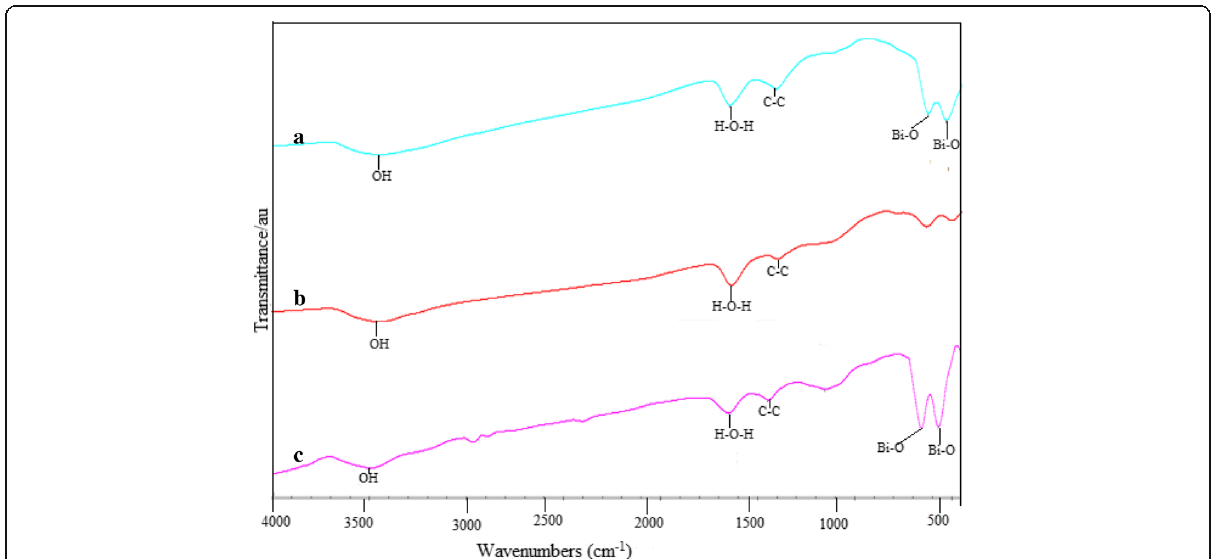
Fig. 2 FT-IR spectra of (a) Bi 2 O 3 nanoparticles, (b) MWCNTs, and (c) Bi 2 O 3 /MWCNT